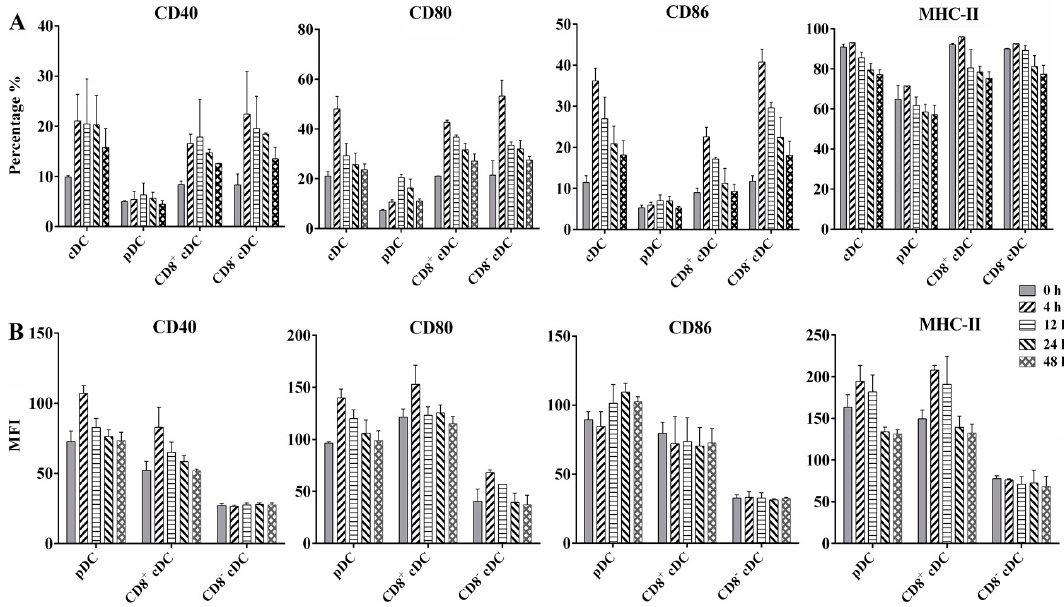
Figure 3. Flow cytometric analysis of surface costimulatory and MHC-II molecules expressed on differential murine splenic DC subsets. WSCs were obtained from naive mice (0 h) or 10 8 BCG injected mice at different time points, and stained with a panel of MAbs to detect CD40, CD80, CD86, and MHC-II on splenic cDC, pDC, CD8 + cDC, and CD8 − cDC. ( A ) Percentage of positive cells is indicated for each panel; ( B ) mean fluorescence intensity (MFI) of surface molecules expressed on different DC subsets; the experiment was repeated four times, and data are shown with the mean value of the four independent experiments. The bar graphs show the mean ± SD.